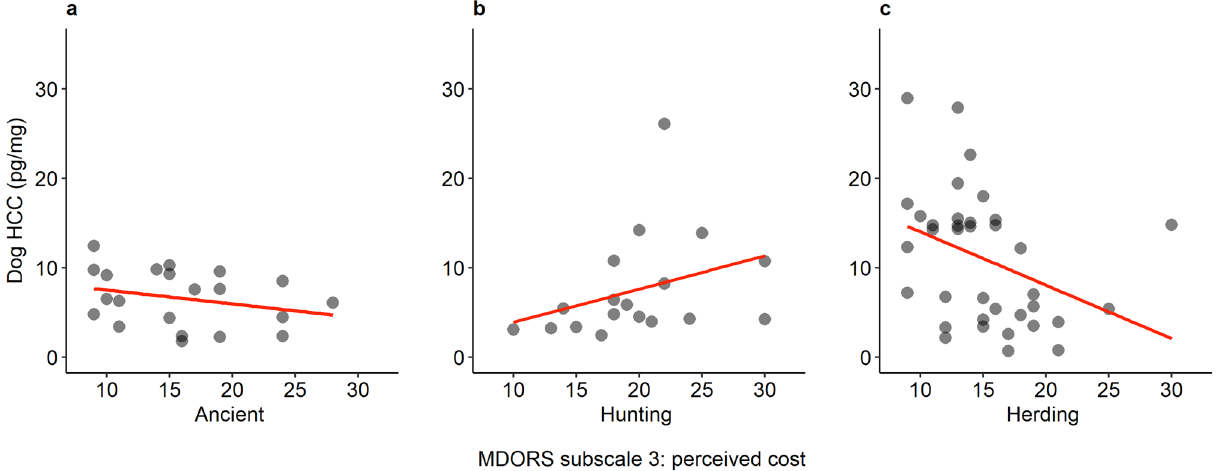
Figure 4. Correlations with included fitted lines between dog HCC (pg/mg) and MDORS 3 - Perceived cost for ancient breeds ( a ), solitary hunting breeds ( b ) and herding breeds ( c ). This image was created using R